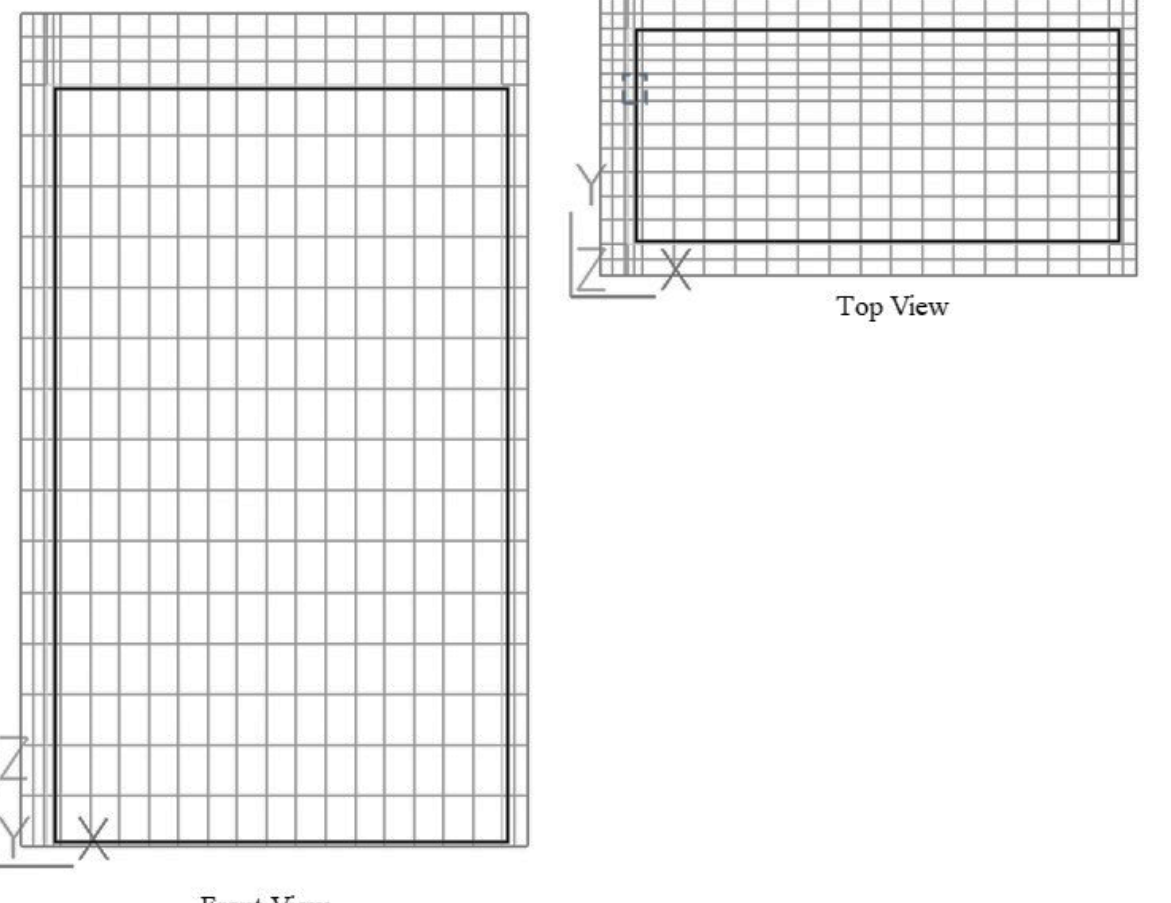
Figure 5. Meshing of chamber model: the dashed line square at top view represents fan ( ). The